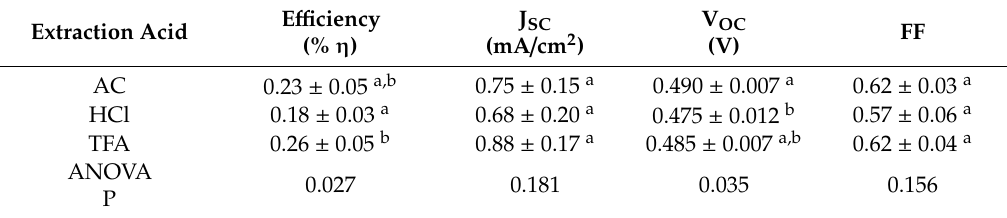
Figure 5. Average J-V curves of six DSSC with different extracts. Table 1. Effect of different extraction acids on the photovoltaic parameters of the DSSC.